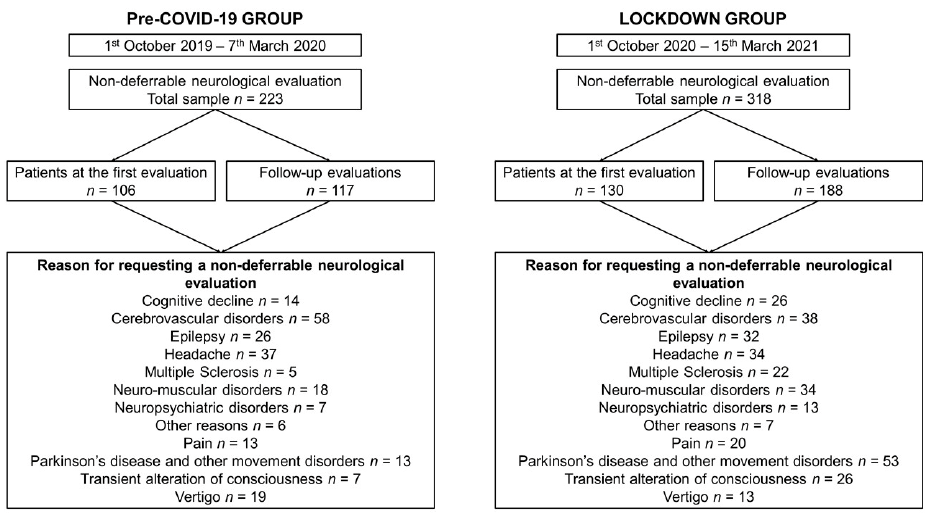
Figure 1. Flow-chart detailing sample selection, patient admission and reasons for requesting a non-deferrable neurological evaluation. Follow-up evaluations indicate patients previously evaluated at the same neurology outpatient clinic. Table 1. Patients’ demographics, reasons for requesting a non-deferrable neurological evaluation, and discharge diagnoses.